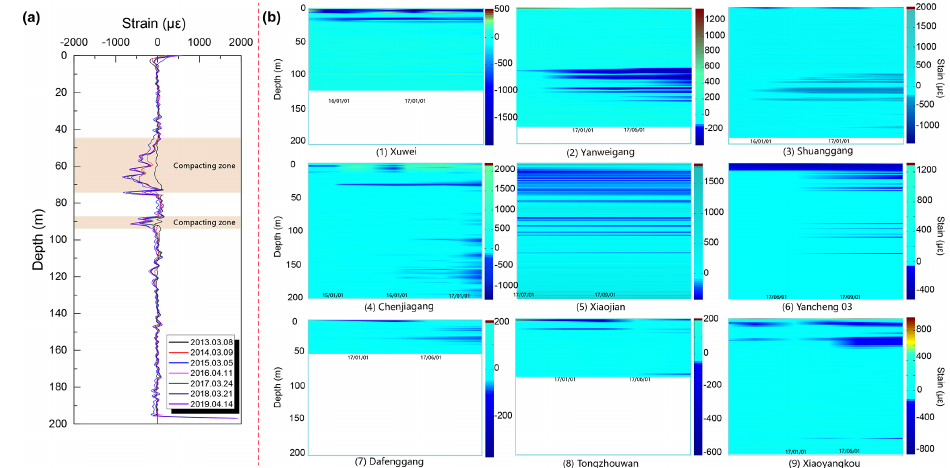
Figure 3. The subsurface deformation obtained by DFOS. (a) Typical strain distribution along the borehole, (b) Subsurface deformations in boreholes in the coastal